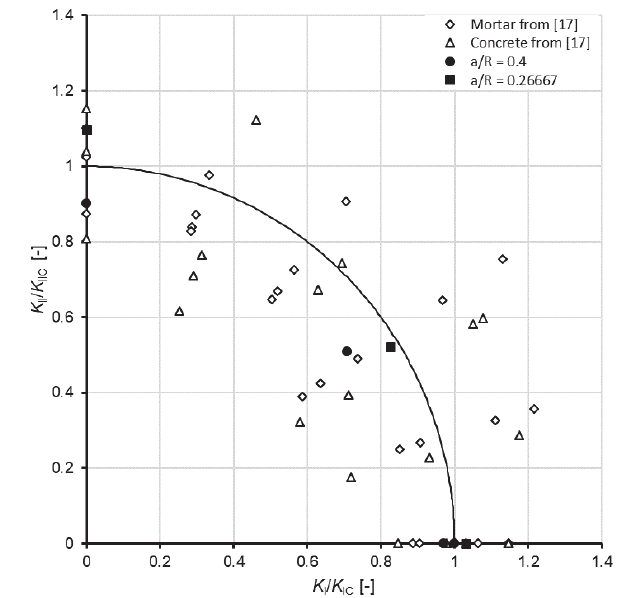
Figure 5: Comparison of fracture resistance K II / K IC ( y axis) against K I / K IC ( x axis) behavior with data from literature [17]. Comparison of experimental data